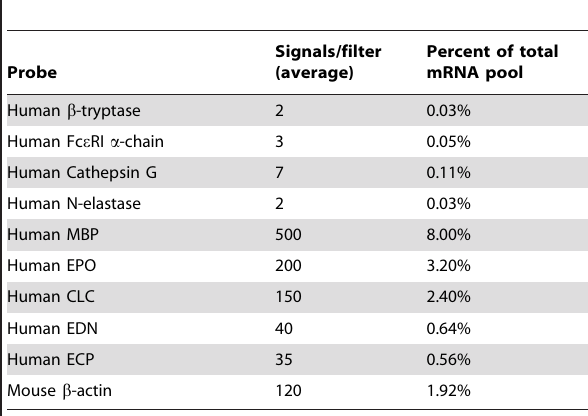
Table 2. Expression levels of lineage specific